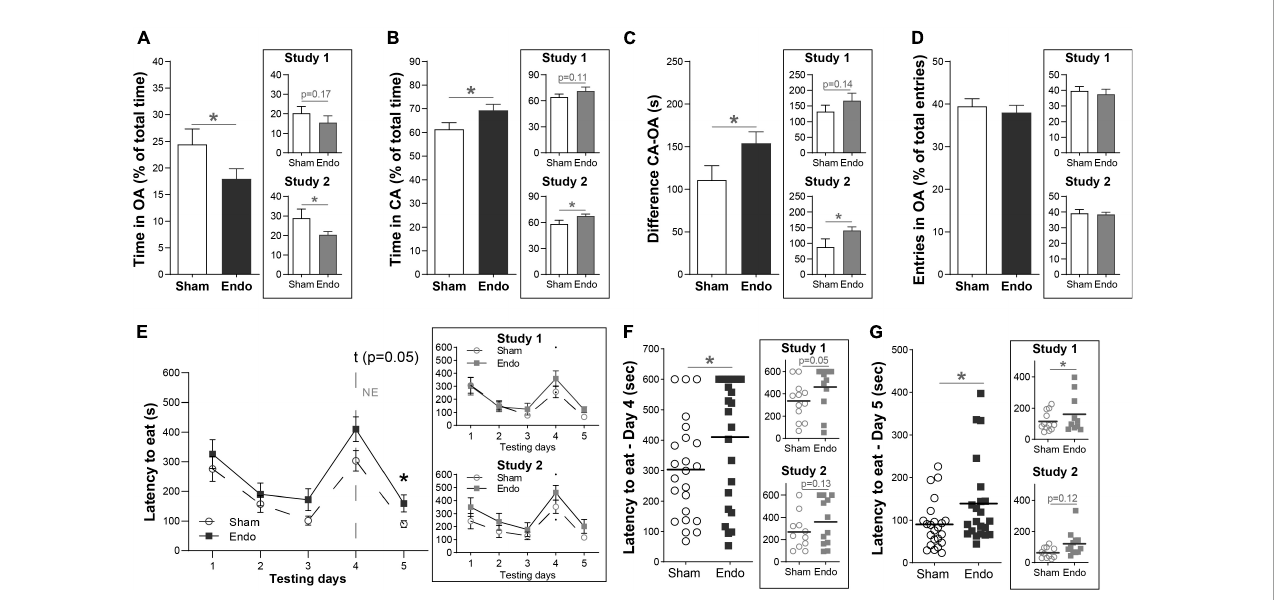
FIGURE3 Anxiety-related behavior in endometriosis-induced mice. (A–D) Measurements of the EPM assay in means of time spent and number of entries between the open and closed arms of the instrument. (A) Comparison of the time spent in the open arm (OA) of the EPM between EIM and sham mice. (B) Comparison of the time spent in the closed arm (CA) of the EPM between EIM and sham mice, shown as percentage from the total time of the assay. (C) Difference between time spent in the CA and the OA of the instrument. (D) Number of entries in the OA, shown as percentage from the total number of entries. (E–G) Measurements of the NEFS assay in means of latency to approach food in a novel, open environment. (E) Mean latency to approach food among testing days between EIM and sham mice. On testing day 4, food and mice were in an open, novel environment. (F,G) Comparison of the latency to approach food on testing day 4 (F) and testing day 5 (G) between EIM and sham mice. Dots represent the value of each mouse. Horizontal bars: mean value within each group. The main panels show data pooled from two independent studies ( n sham = 23, n EIM = 24), each of them shown separately in insets (study 1: n sham = 12, n EIM = 12; study 2: n sham = 11, n EIM = 12). Data shown as mean ± SEM. * = p <